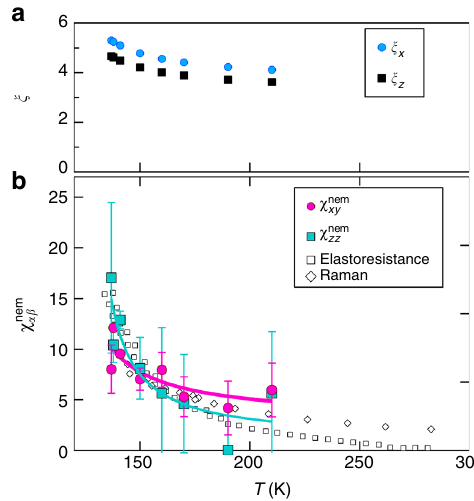
Fig. 4 Temperature dependence of the nematic susceptibilities. a Correlation lengths ξ x,z (0) at zero strain, and b nematic susceptibilities χ nem fi ts (solid lines) shown in Fig. 2. Also xy ; zz vs. temperature, based on the shown are the nematic susceptibilities measured by Raman and elastoresistance measurements, reproduced from refs. 35 – 37 , respectively. The solid lines are fi ts as described in the text. The error bars are determined from least squared minimization fi ts, holding the ξ x,z (0) parameters fi xed, as described in Supplementary Note